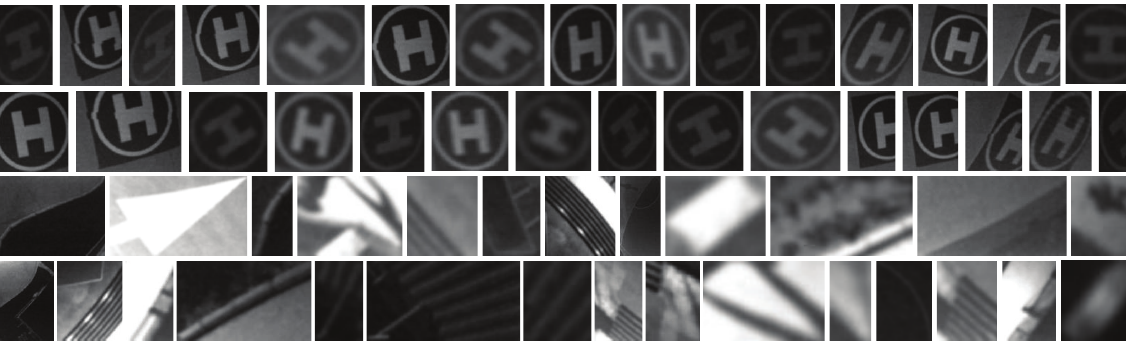
Figure 5. Selected images from the training dataset.